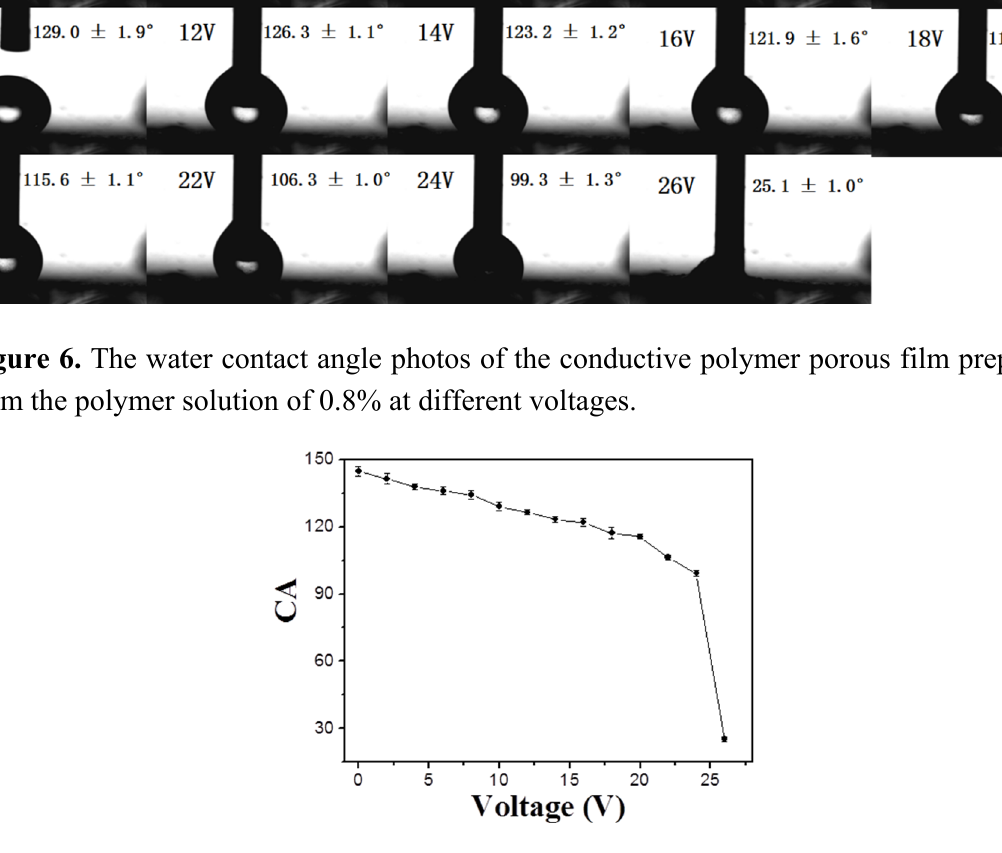
Figure 7. The contact angles (CAs) of the porous film prepared from the solution of 0.8% at different